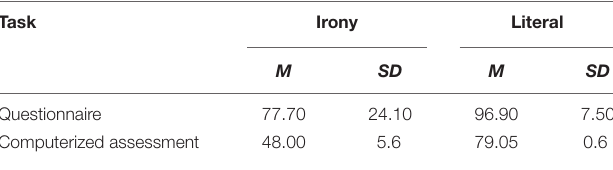
RVF/LH ( M = 941.84, SD = 46.81, p < 0.01. The